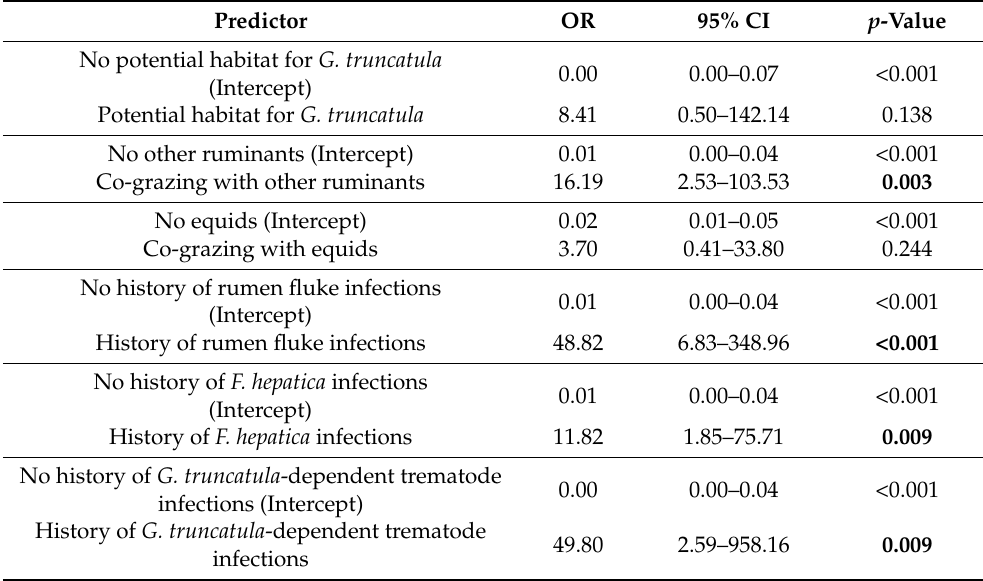
Table 7. Results of simple logistic regressions: predictors for patent rumen fluke infections in sheep flocks.